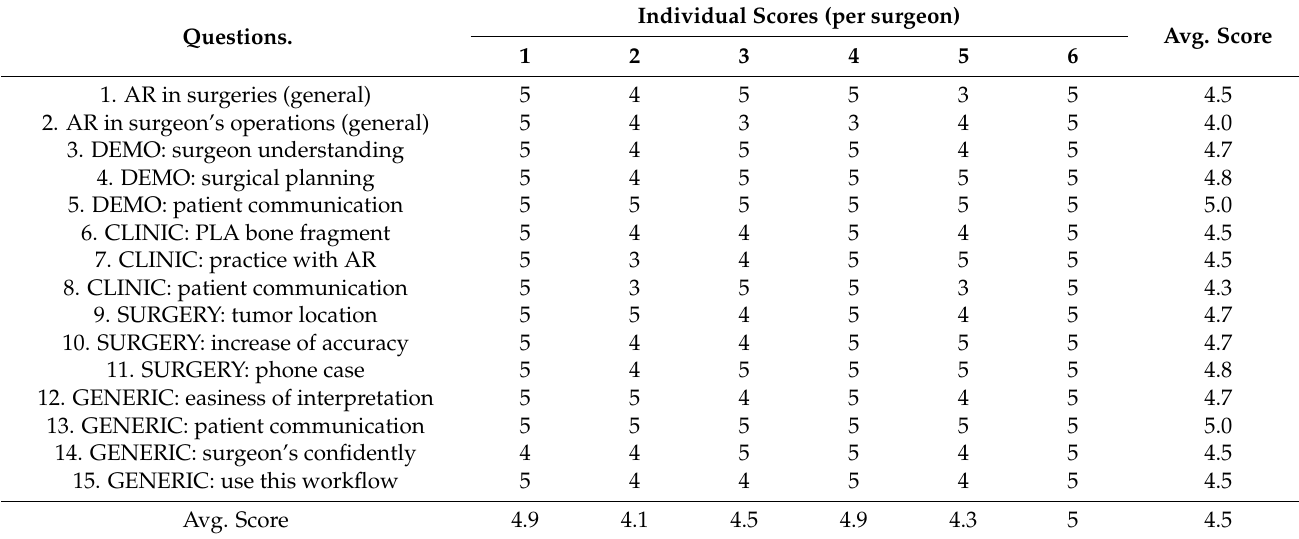
Table 4. Surgeons’ survey scores.